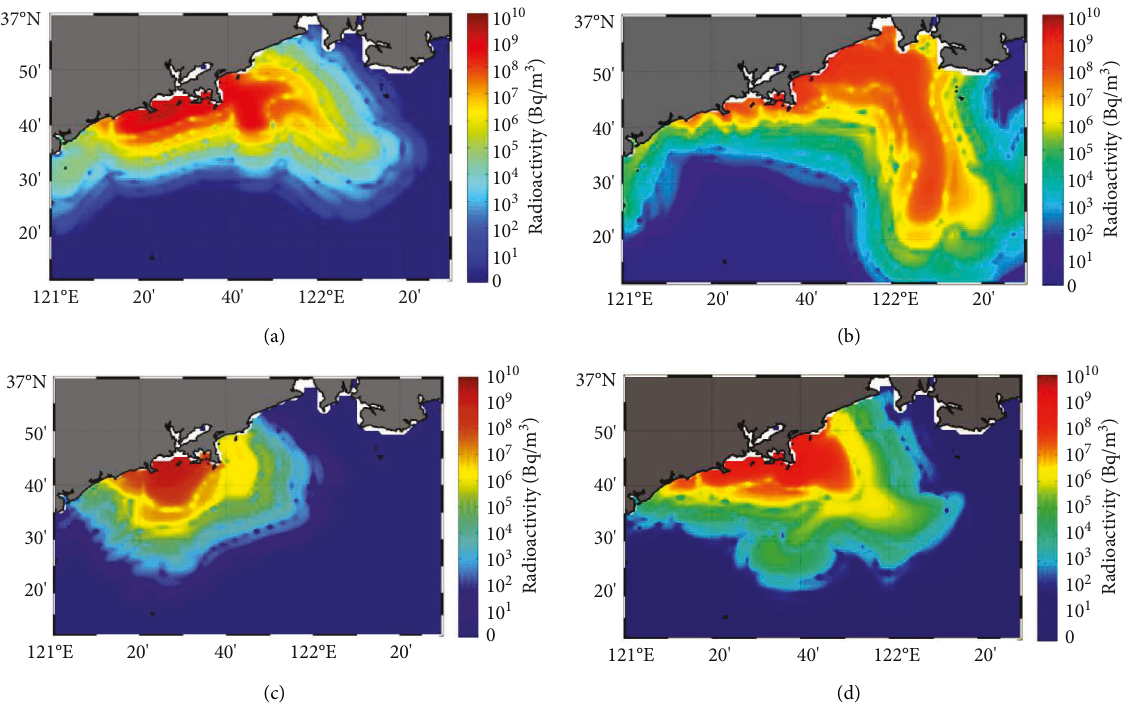
Figure 3: Surface diffusion of 137 Cs in two weeks of summer and winter. (a) The 7th day in winter. (b) The 14th day in winter. (c) The 7th day in summer. (d) The 14th day in